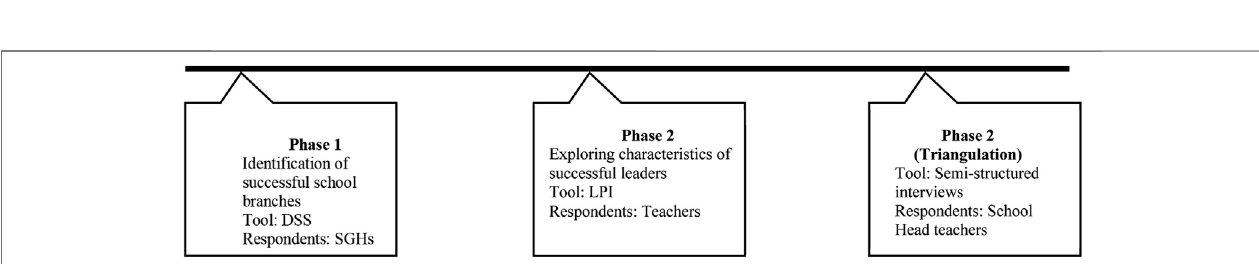
FIGURE 1 | Organizational Structure of the Beaconhouse School System and Research Population.